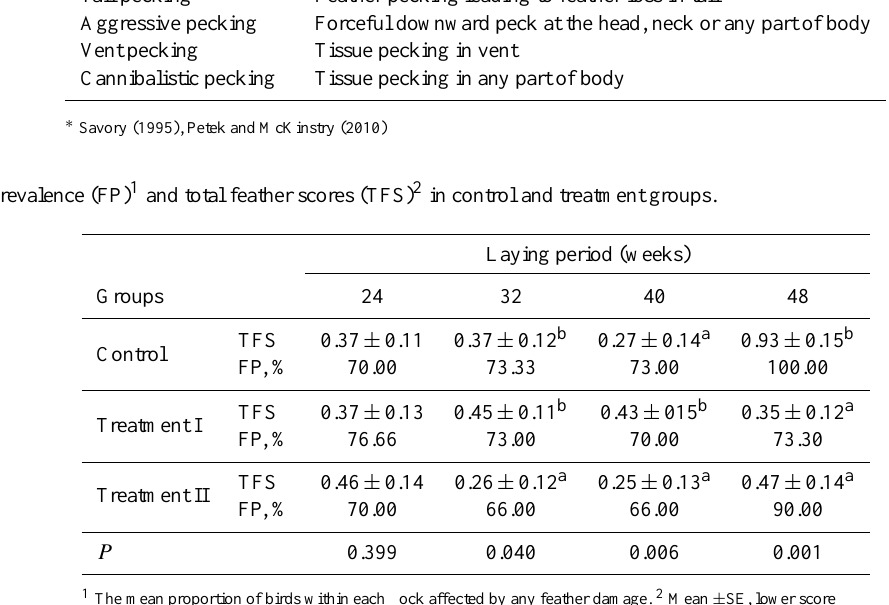
Table 1. Ethogram of behavioural observations ∗ .